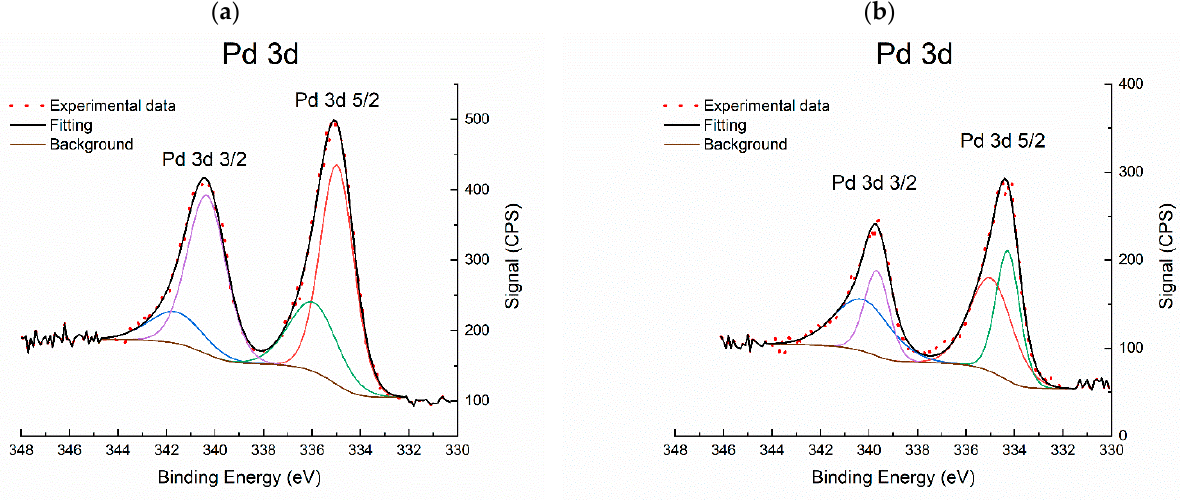
Figure 6. Pd 3d XPS X-ray photoelectron spectroscopy (XPS) region of: ( a ) red(400 °C)-Pd/ γ -Al 2 O 3 and ( b ) red(600 °C)- Pd/ γ -Al 2 O 3 .